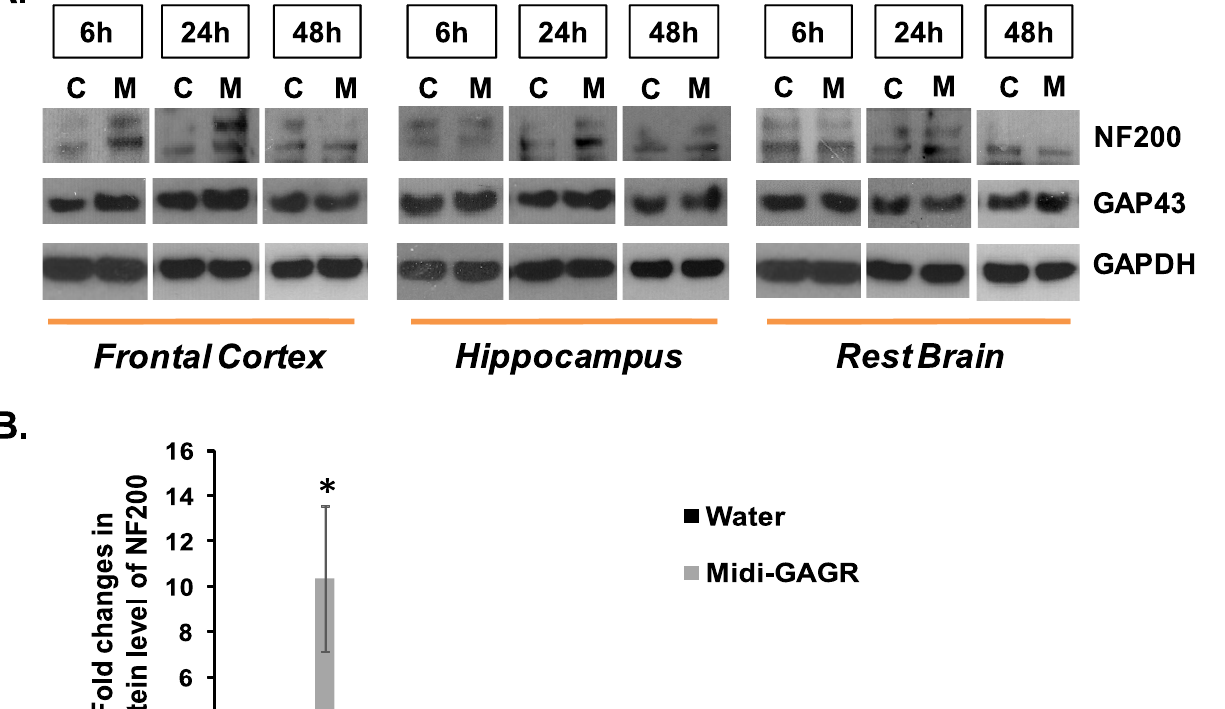
PLOS ONE | DOI:10.1371/journal.pone.0149715 March 3,